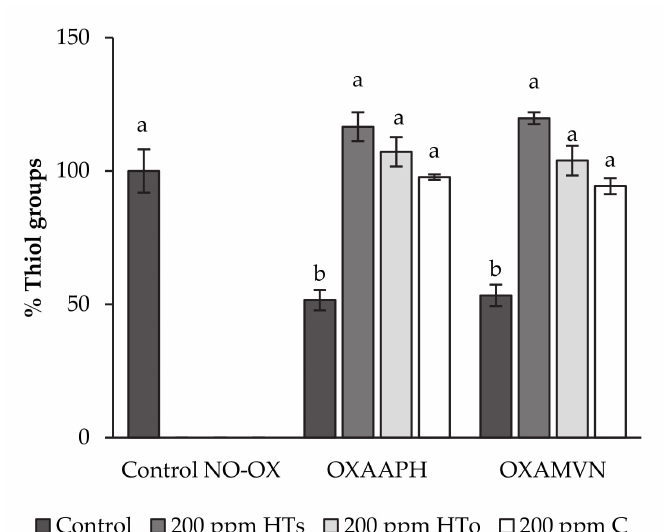
Figure 1. Percentage thiol groups in meat model systems oxidized by AAPH (OX AAPH ) or AMVN (OX AMVN ) after addition of phenolic extracts (HT s (200 ppm), HT o (200 ppm), and C (200 ppm) relative to a control meat model system with no oxidant (Control NO-OX). Different letters (a and b) indicate significant differences among samples ( p <